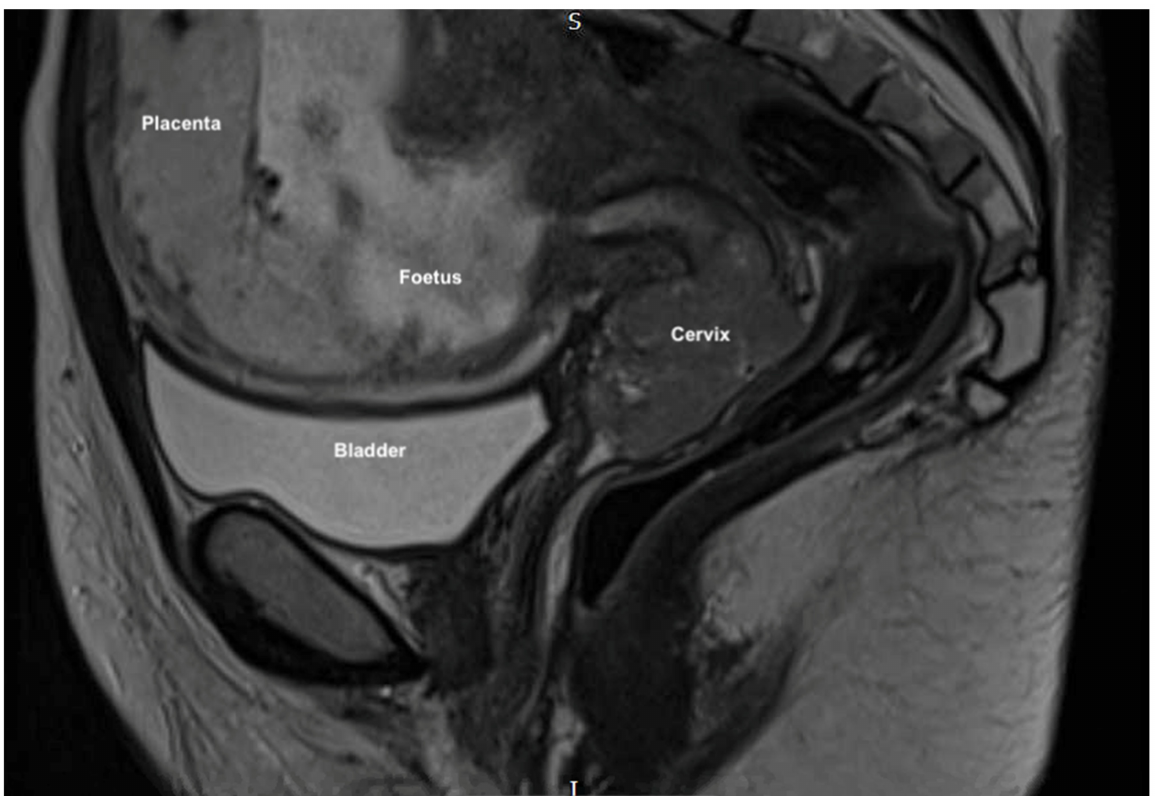
Figure 1. MRI sagittal scan showing the gravid uterus, anteverted and anteflexed, with a single foetus in cephalic presentation with cervical mass seen distally.